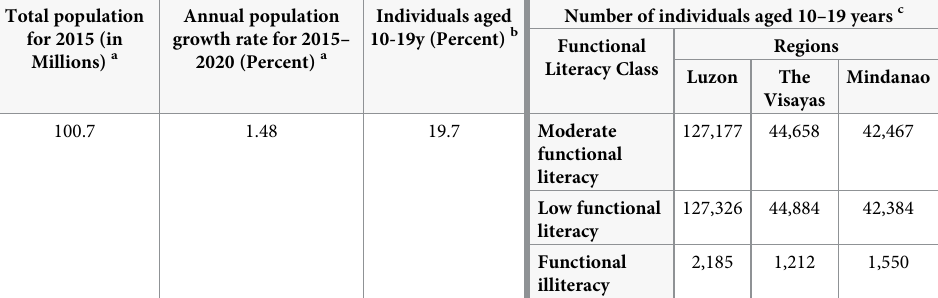
Table 10. Predicted number of school-aged children (10 to 19 years old) in each functional literacy class in the Philippines in 2017. Total population for 2015